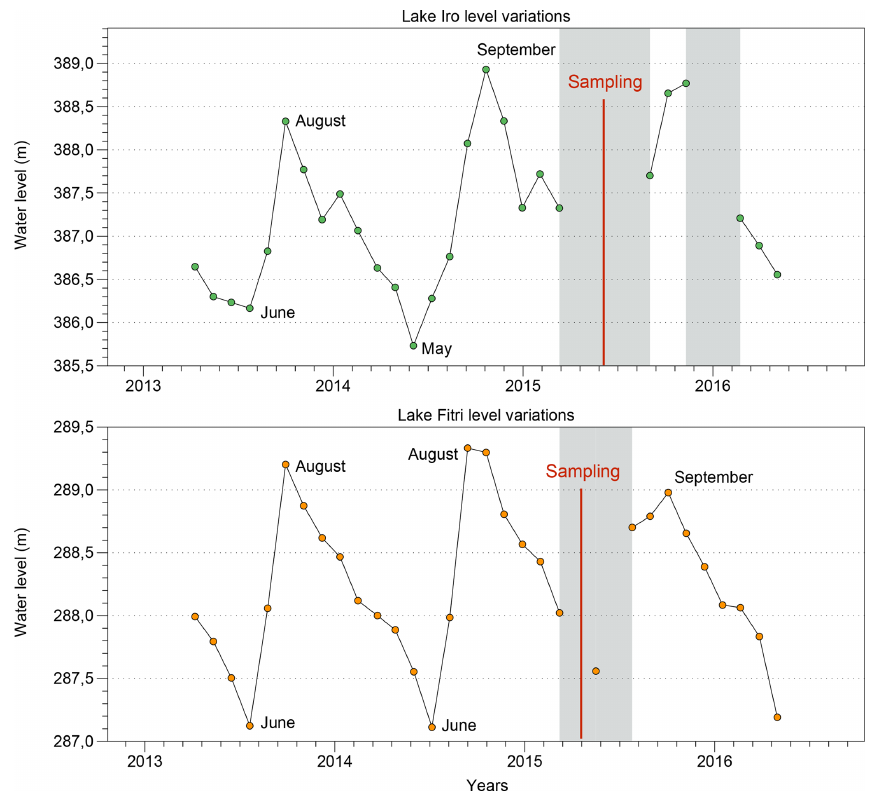
Figure 5. Lake level variations from altimetry data (SARAL satellite) for Iro Lake (in green) and Lake Fitri (in orange). Data cover the period from 2013 to the beginning of 2016. The grey zones represent a lack of data, and the red line indicates the period of sampling. Variations in lake level show a maximum of 3.5m for Iro and of 2.5m for Fitri during 2014. The maximum level is observed around August and September, and the minimum is in May–June for both lakes.